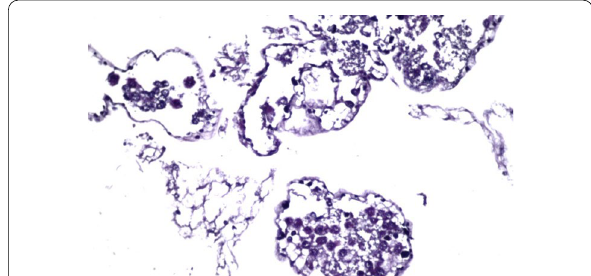
Fig. 3 Showed ovotestis of treated M . vermiculata with sodium carbonate. Necrobiotic change was detected in the ova and some follicles, associated with diminished in the spermatozoal concentration